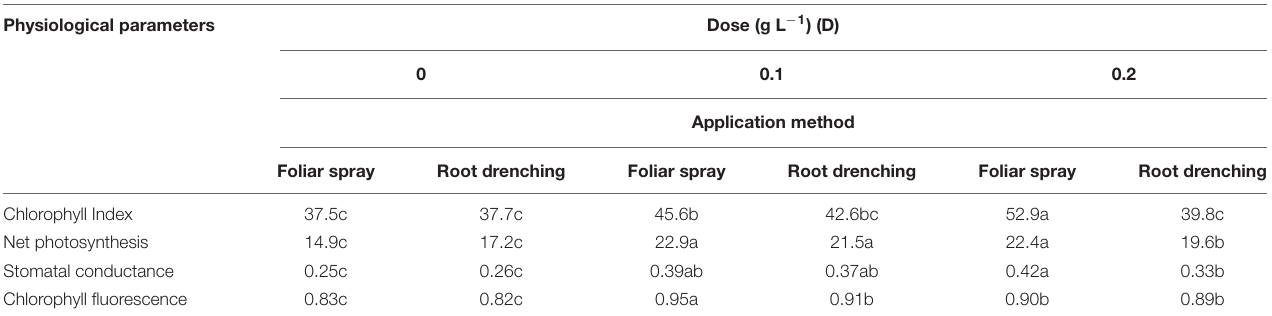
TABLE 6 | Dose × method interaction of animal-derived PH biostimulant on chlorophyll index (SPAD), net photosynthesis ( µ mol CO 2 m − 2 s − 1 ), stomatal conductance (mmol